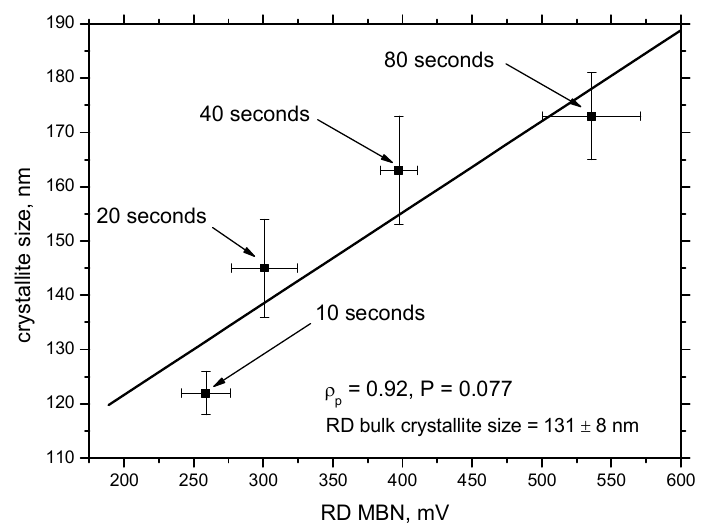
Figure 14. MBN (RMS value) versus crystallite size.